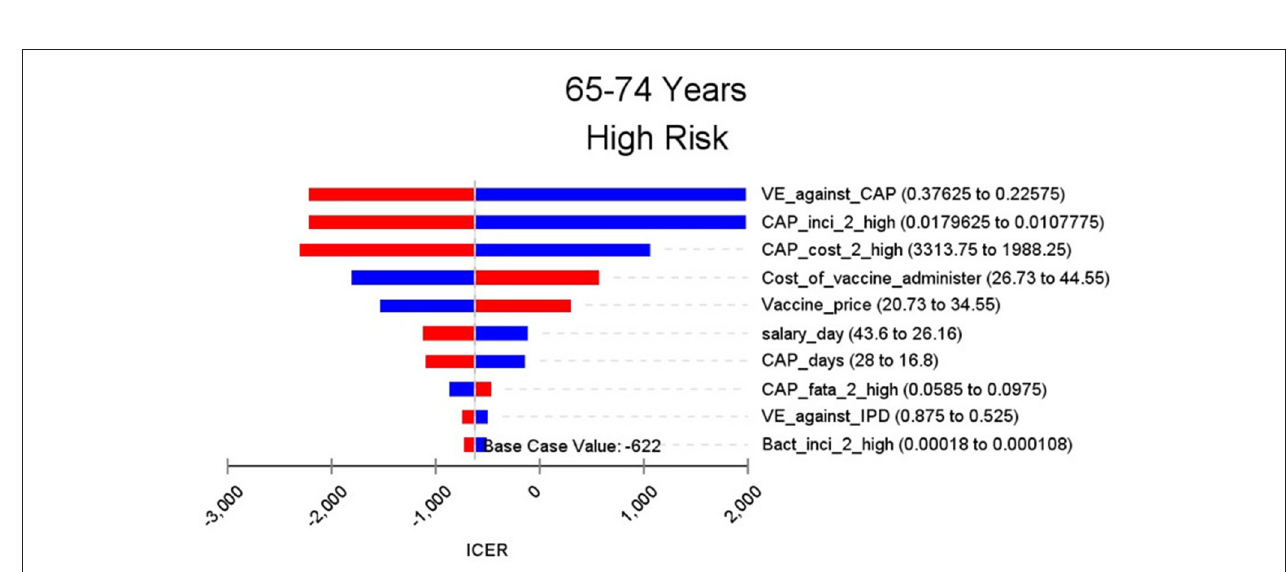
FIGURE 5 | Sensitivity analysis in group 65–74 years and high